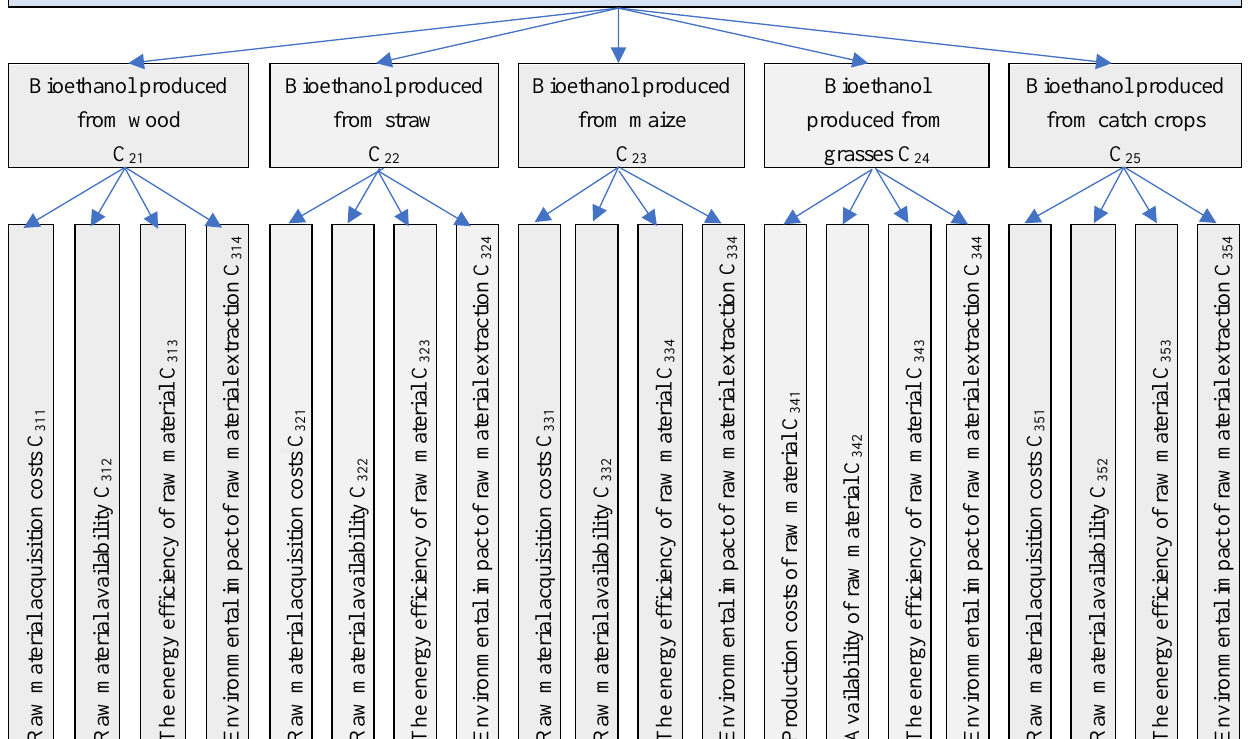
Figure 4. Input elements for event tree analysis (ETA) assessing the main criteria ( C ) of the development of generation II bioethanol production from various energy sources in Poland. The presented tree shows a top-down, inductive procedure structuring the bioethanol production possibilities from different raw materials. C 1 — initial event of bioethanol production possibilities; C 2X — level of factors assessing the various substrates for bioethanol production; C 3X — level of factors assessing the cost, technical, and environmental aspects of bioethanol production from a given raw material.